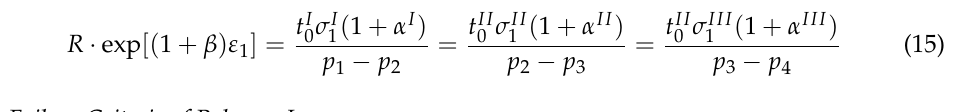
Figure 2. Structure of the three-layered sandwich panel.